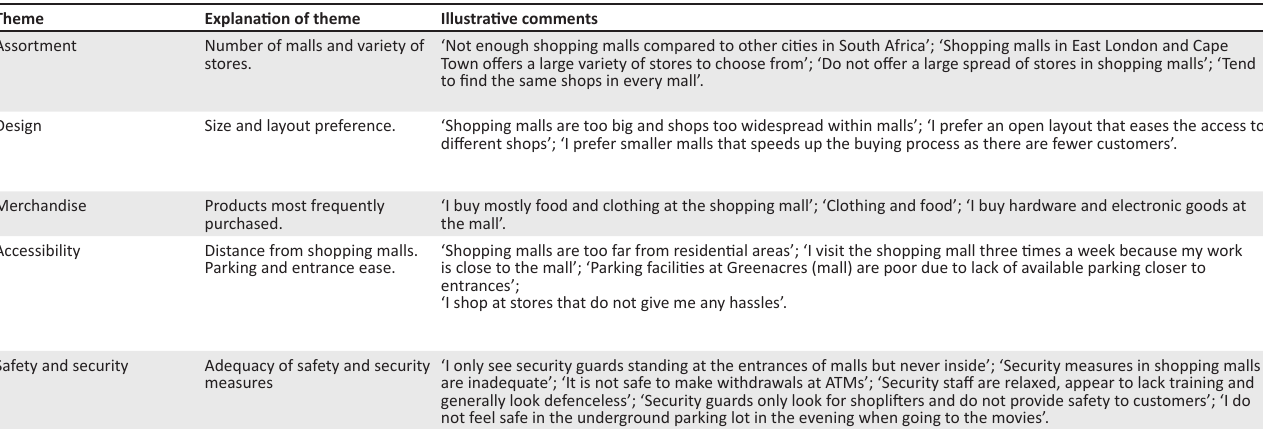
TABLE 1: Consumers’ perceptions of shopping malls in Port Elizabeth.